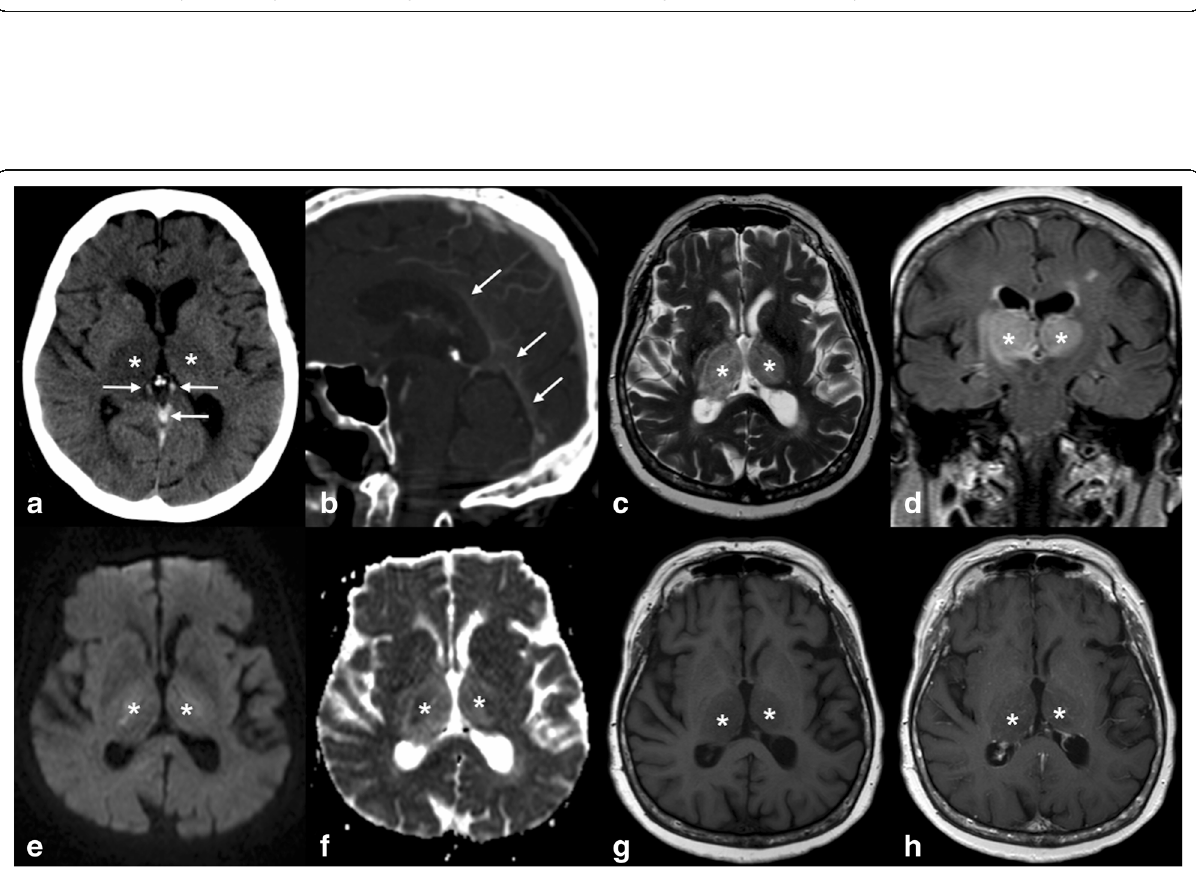
Fig. 12 DWI illustrates hyperintensity of both thalami (arrows in a ), the lentiform nuclei (arrowheads in a ), and caudate (asterisk in a ) following cardiac arrest. Note hyperintensity in the same regions on T2WI ( b ) corresponding to ischaemia due to hypoxia